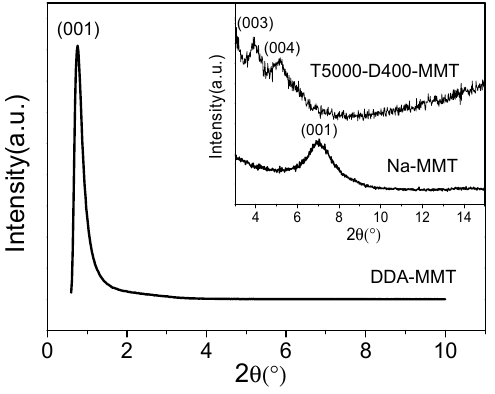
Figure 3. SAXS pattern of DDA-MMT and XRD patterns of T5000-D400-MMT and Na-MMT (inset).